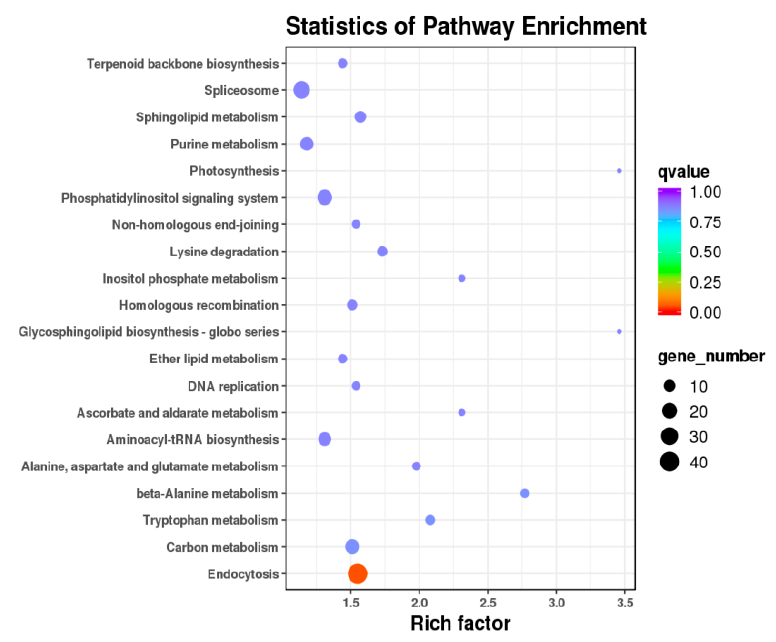
Figure 6. KEGG pathways of differentially expressed miRNA target genes in the CS and CON groups .